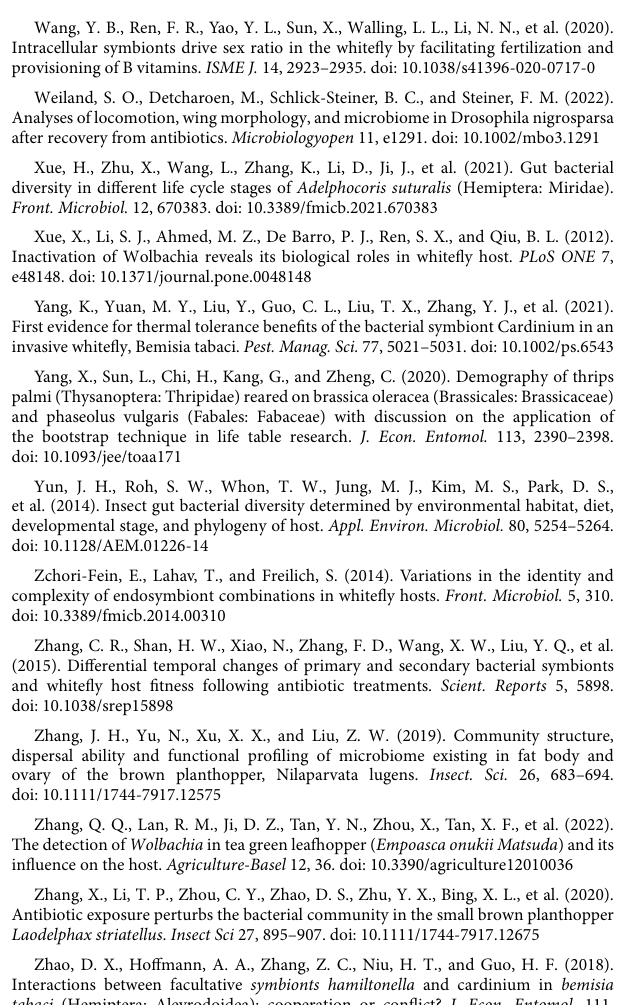
tabaci (Hemiptera: Aleyrodoidea): cooperation or conflict? J. Econ. Entomol. 111, 2660–2666. doi: 10.1093/jee/toy261 Zhao, D. X., Zhang, Z. C., Niu, H. T., and Guo, H. F. (2020). Selective and stable elimination of endosymbionts from multiple-infected whiteflyBemisia tabaciby feeding on a cotton plant cultured in antibiotic solutions. Insect Sci. 27, 964–974. doi: 10.1111/1744-7917.12703 Zhou, X. (2018). Interactions between Bemisia Tabaci and Its Endosymbionts Wolbachia and Cardinium and Their Biological Effects on the Host . China Agricultural